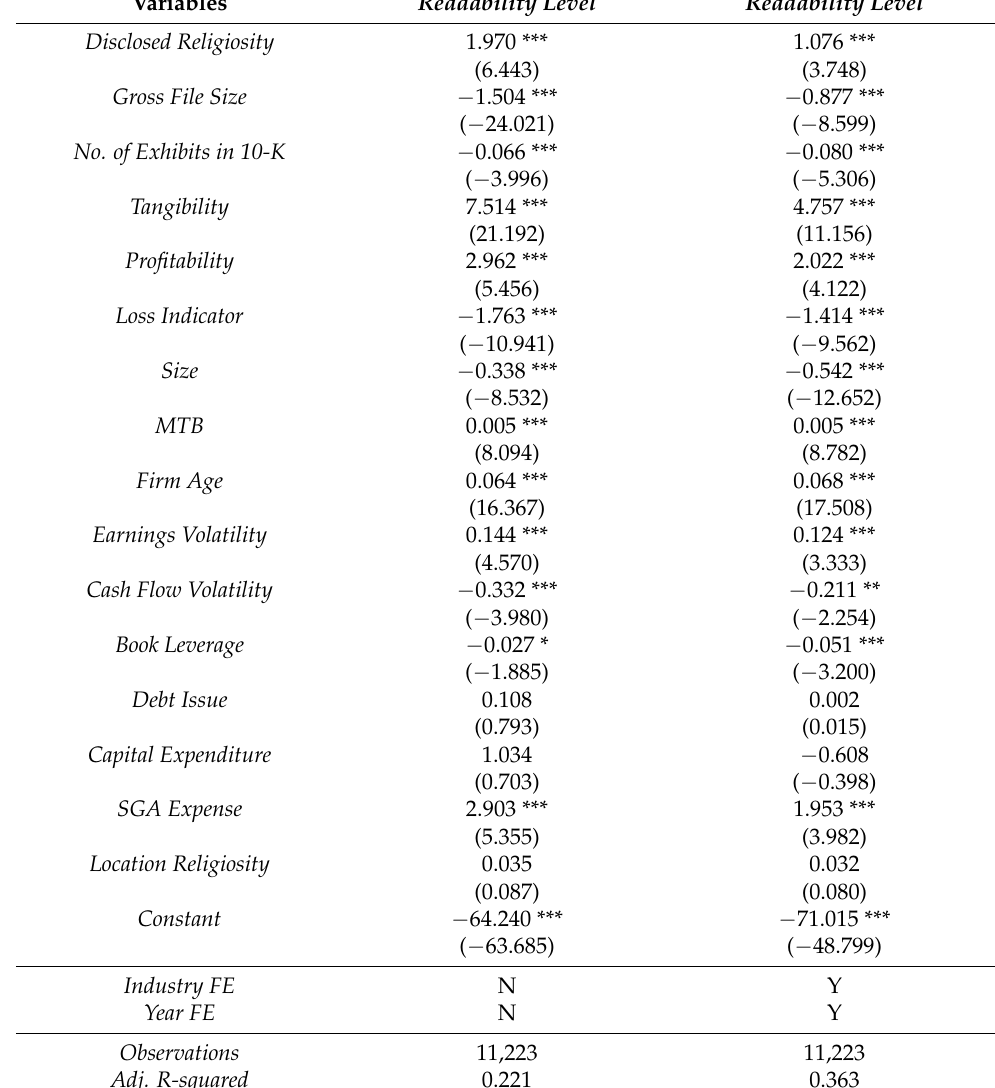
Table 5. Impact of Executive Level Religiosity on Annual Report Readability—Christian